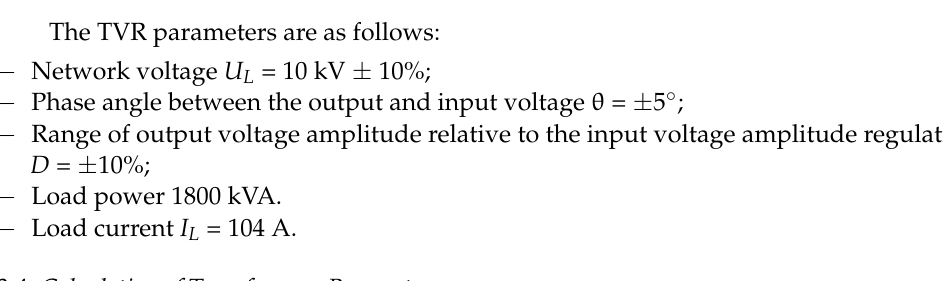
Table 2. Load data.